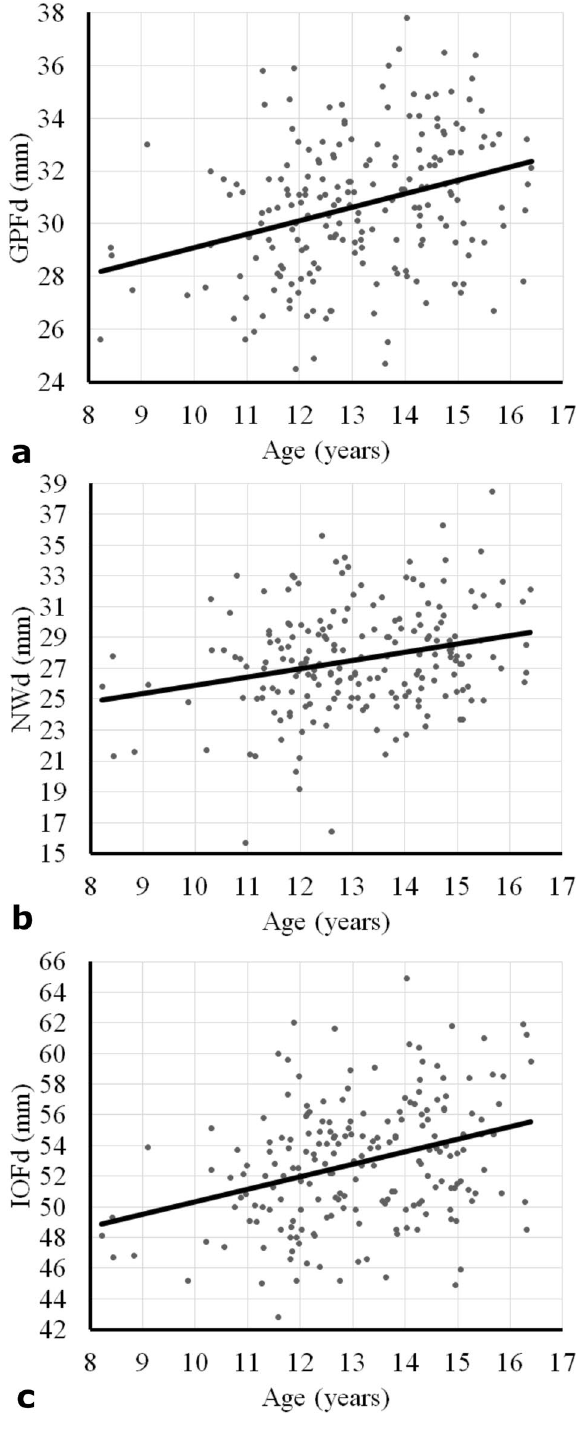
Figure 6. Scatter plots with regression lines illustrating the average dimension by age. ( a ) distance between lateral margins of the greater palatine foramina (GPFd), ( b ) distance between lateral walls of the nasal cavity (NCd), and ( c ) distance between lateral margins of the infraorbital foramina